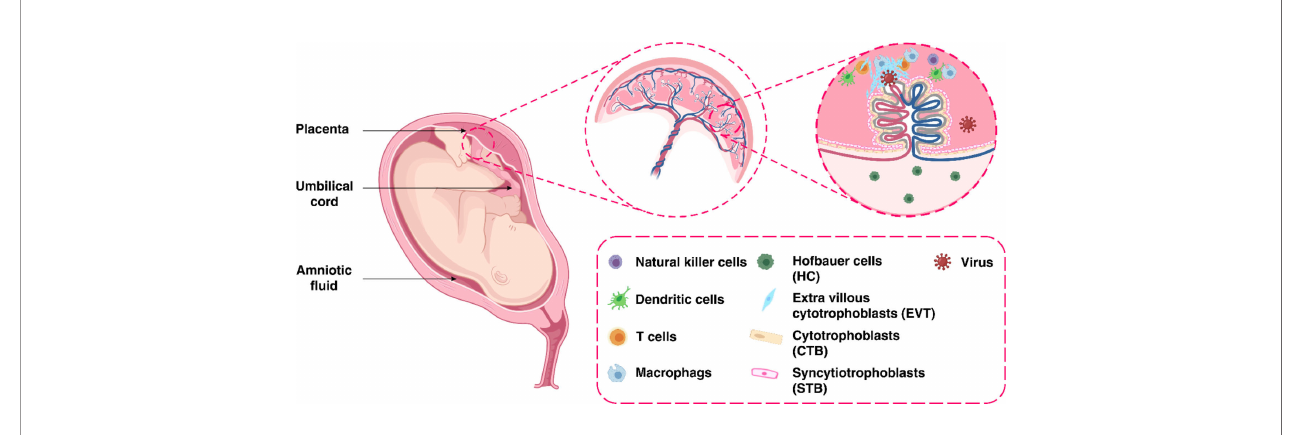
FIGURE 2 | The maternal-fetal interface.